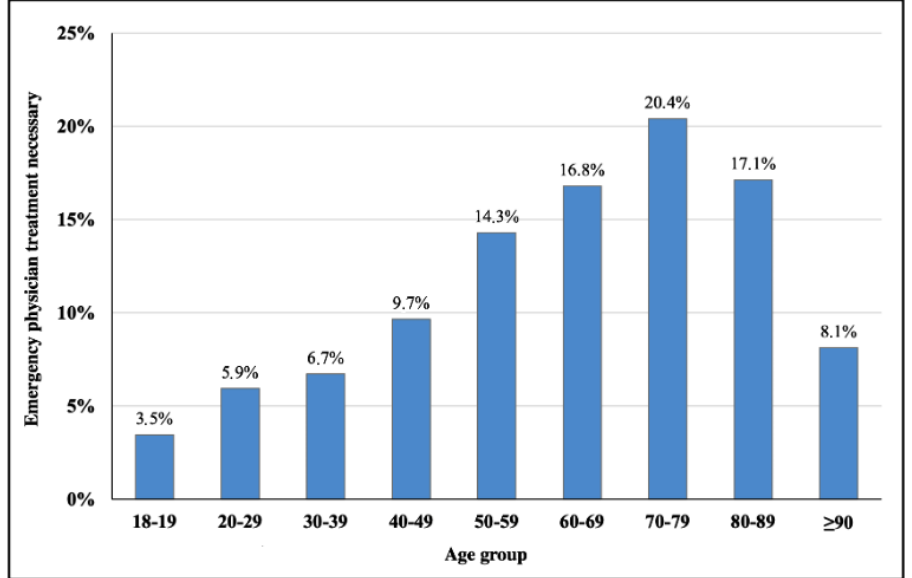
Figure 3. Therapy by prehospital emergency physicians in Vienna by age group (2012 – 2019).